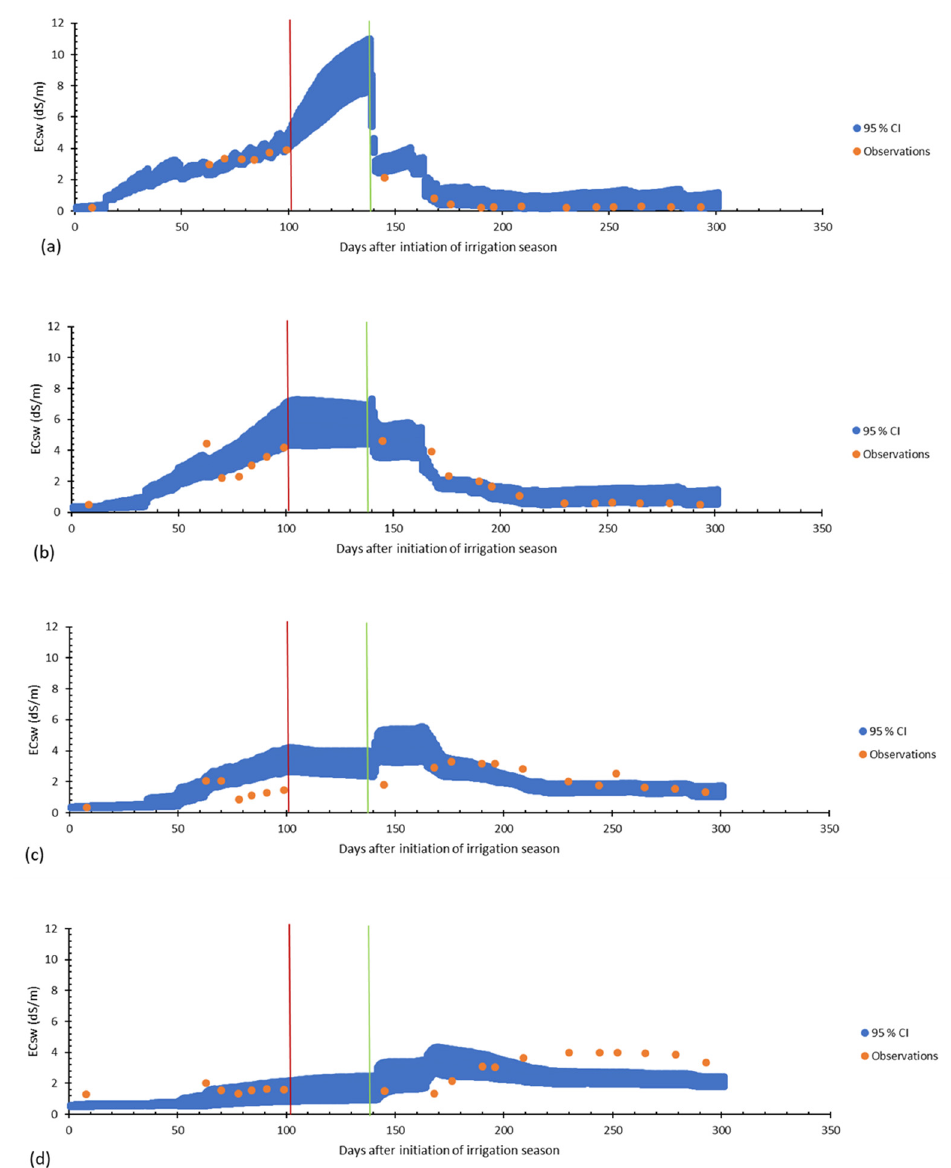
Figure 5. Predictive uncertainty for simulating soil salinity dynamics during and out of growing season at ( a ) 10 ( b ) 30 ( c ) 50 and ( d ) 70 cm soil depth. Orange dots are measured values and blue bands are predictive uncertainty for parameters 95 CI. Table 8. Evaluation of the predictive uncertainty of the HYDRUS-1D model regarding soil salinity dynamic